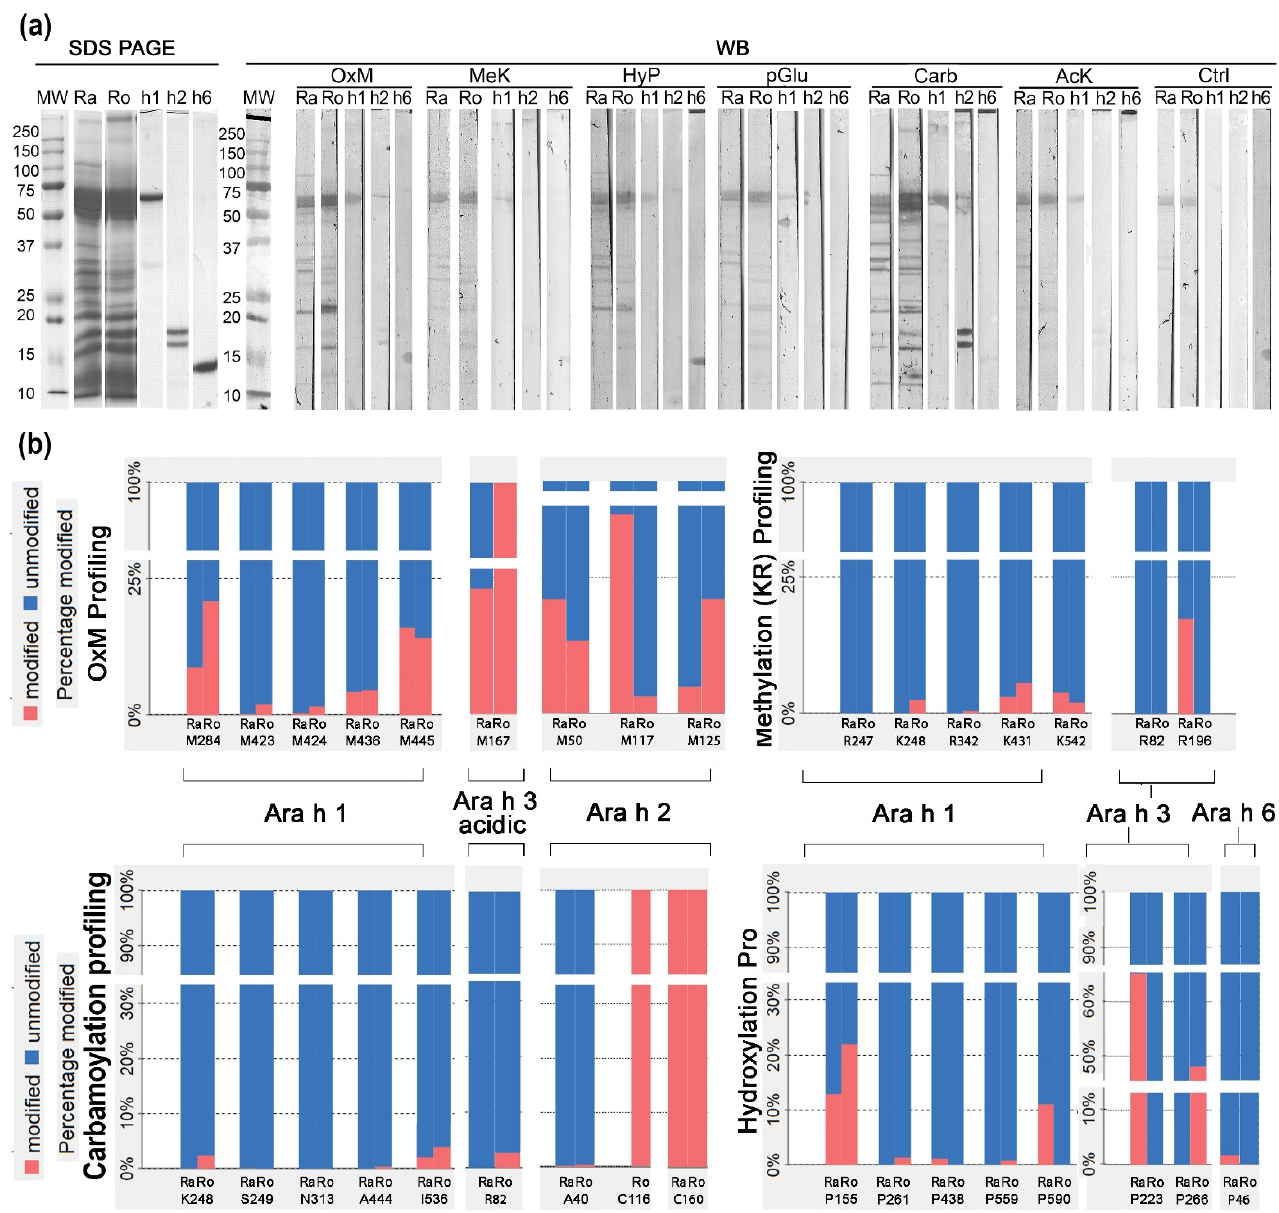
Figure 3. 1D immunoblots of protein post-translational modifications (PTMs) of the raw and roasted peanut extracts, purified allergens, and representative examples of relative PTM profiling by tan- dem mass spectrometry and PEAKS PTM relative profiling tool. ( a ) Immunoblot with rabbit IgG antibodies specific to methionine sulfoxide (OxM), methyl-lysine (MeK), hydroxy-proline (HyP), pyroglutamate (pGlu), carbamyl-lysine (Carb), and acetyl-lysine (AcK). Proteins were resolved on 14% polyacrylamide gel in reducing conditions. Goat anti-rabbit IgG conjugated with alkaline phos- phatase was used as the secondary antibody. ( b ) PTM-profiling tool that delivers relative saturation of site-specific PTMs by PEAKS X Pro Studio. Legend: WB—western blot, Ra—raw PE, Ro—roasted PE, h1—Ara h 1, h2—Ara h 2, h6—Ara h 6, Ctrl—control without primary antibody.